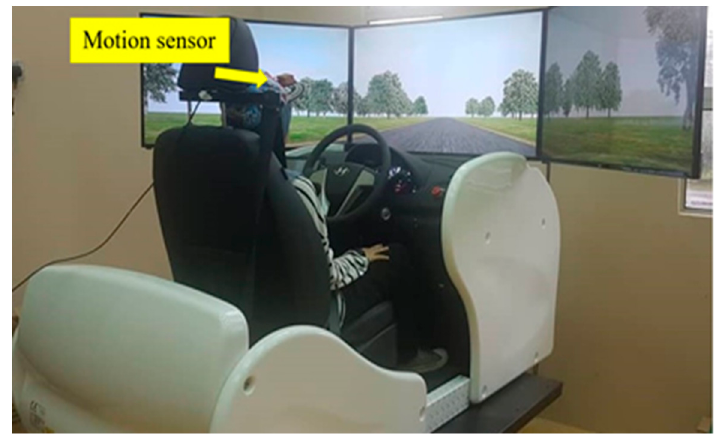
Figure 9. Overview of a participant sitting on the simulator.